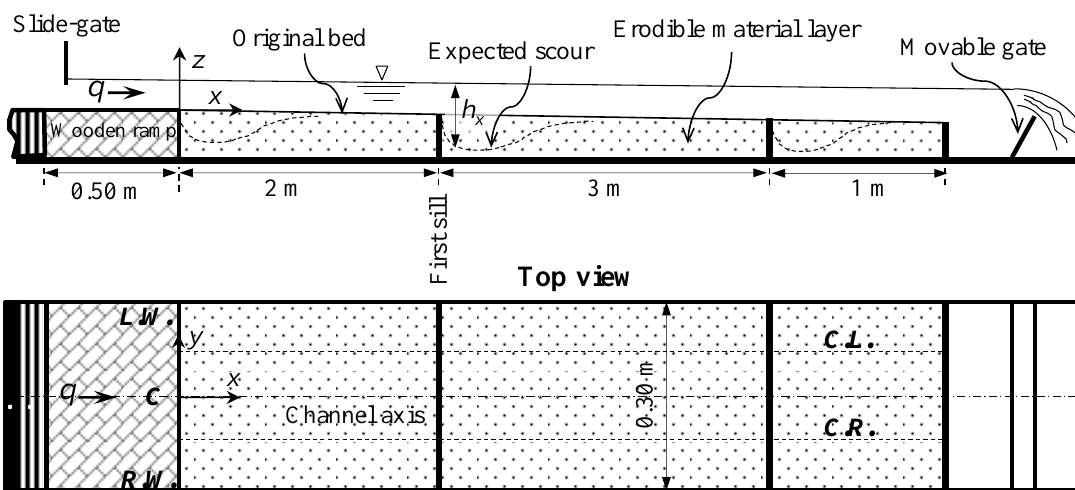
Figure 1. General sketch of the laboratory flume with the initial condition and expected scour hole (dashed profile) downstream of bed sills. h x = flow depth in the expected equilibrium scour at a downstream position x , L.W. = left wall side of channel, R.W. = right wall side, C = centerline (channel axis), C.L. = centerline of left half of channel, and C.R. = centerline of right half, ( x , y , z ) = longitudinal, transversal, and vertical directions, respectively.